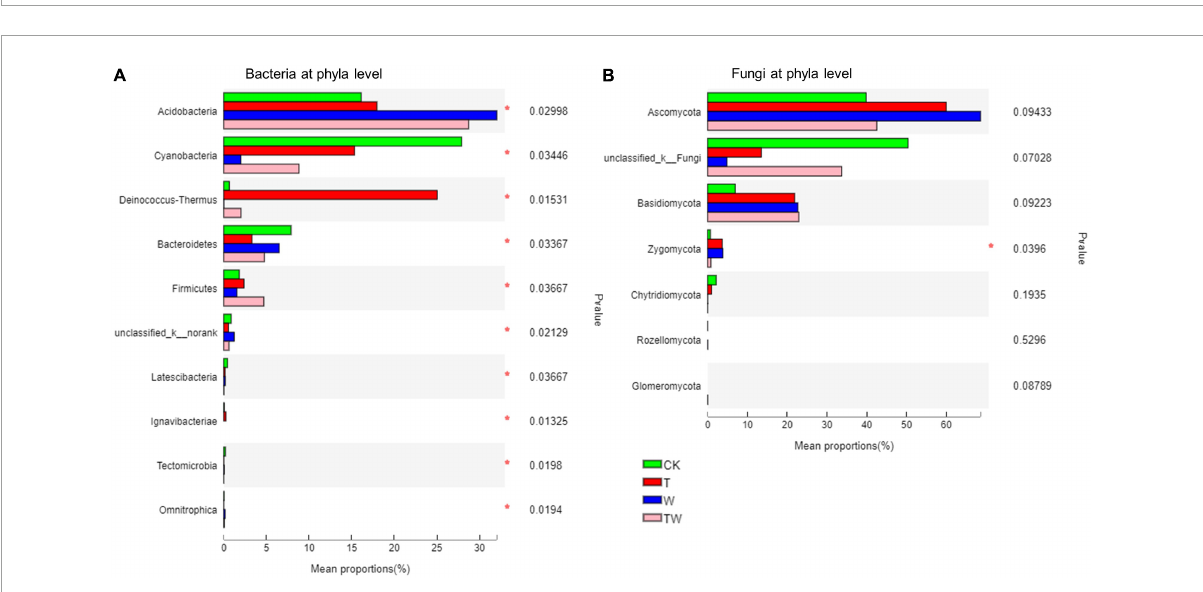
FIGURE6 Soil bacterial (A) and fungal (B) community proportion at the phyla level. (*) Indicates statistically significant differences among the treatments. CK, control; T, increasing temperature; W, increasing precipitation; TW, their interaction.